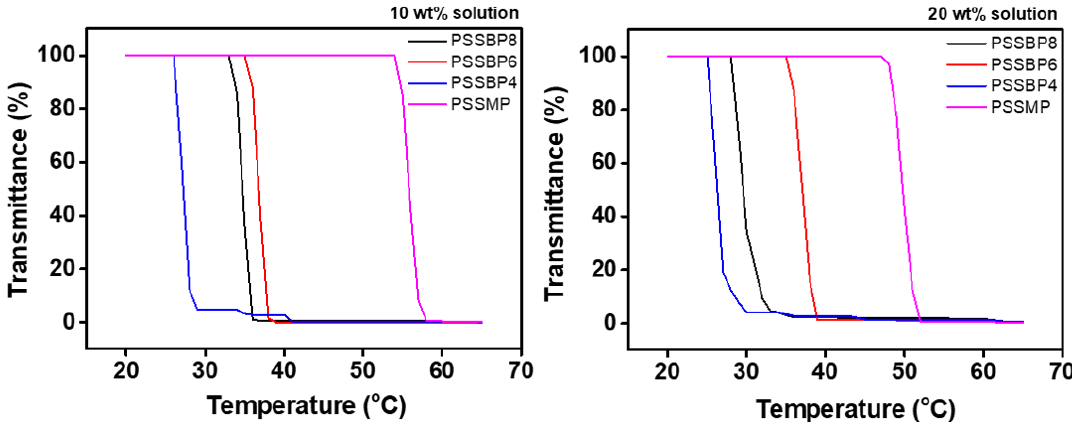
Figure 7. Transmittance curves of PSSBP# series and PSSMP aqueous solutions according to temperature variation.